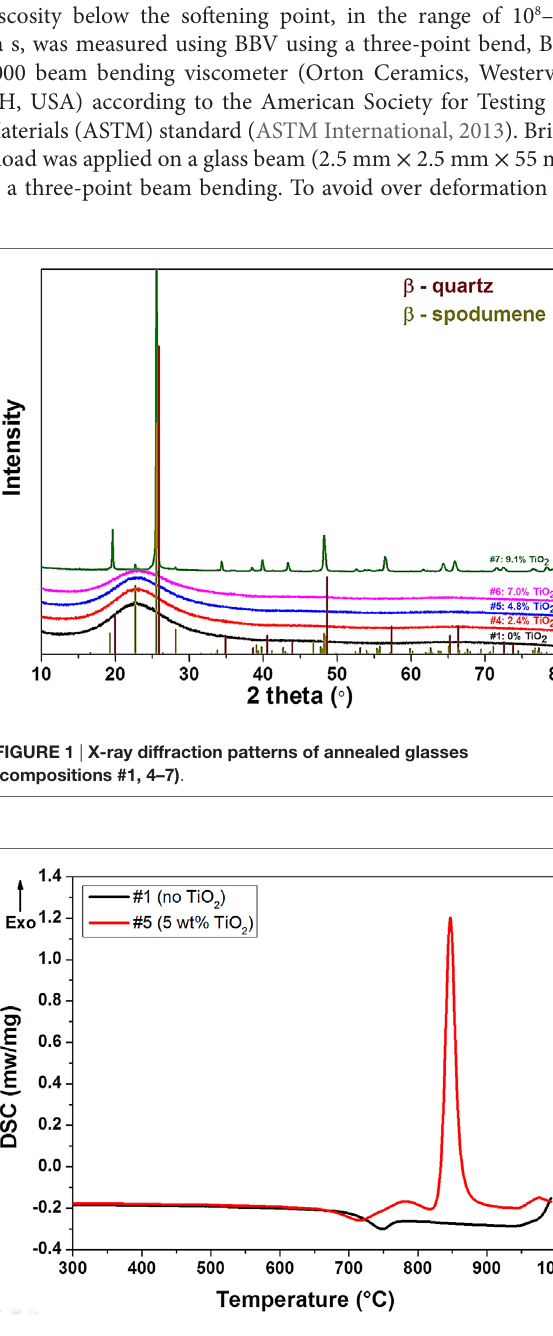
FigUre 2 | Differential scanning calorimetry of glass compositions #1 and 5 .